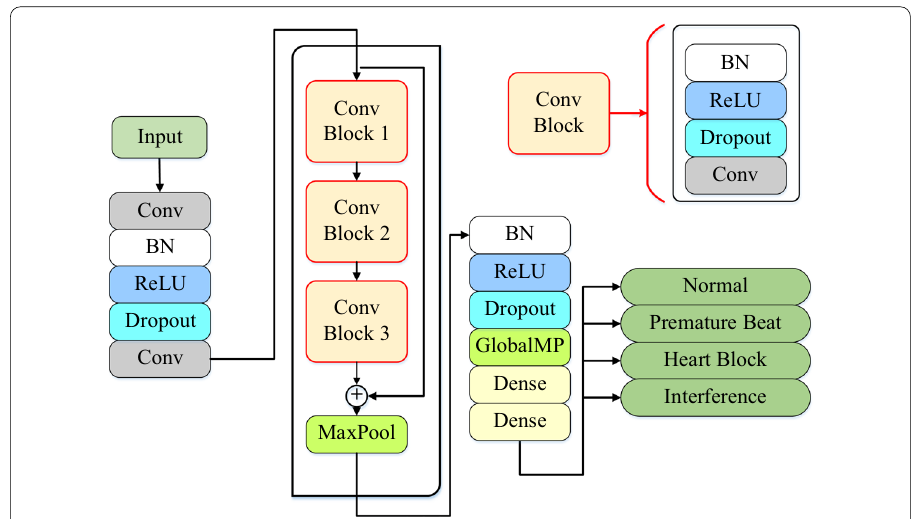
Fig. 6 Structure of the proposed 1D-CNN